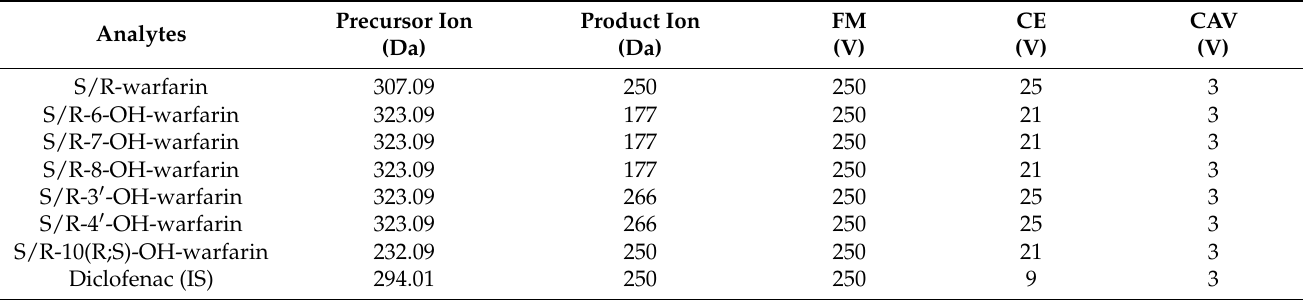
Table 1. Mass spectrometric parameters of the individual